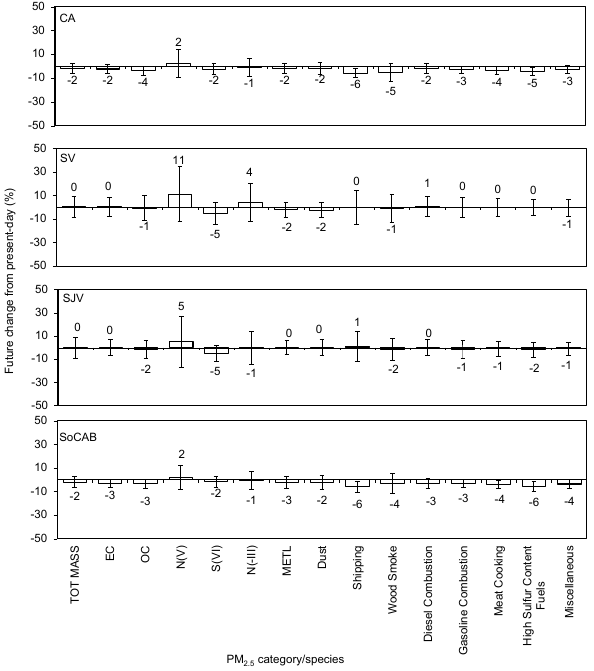
Fig. 2. Future (2047–2053) change in population-weighted annual-average concentrations of PM 2 . 5 total mass, primary and secondary components, and source categories contributing to the total mass from present-day (2000–2006). Panels (top-down) show California state-wide average, Sacramento Valley (SV) air basin average, San Joaquin Valley (SJV) air basin average, and South Coast Air Basin (SoCAB) average results. The error bars represent the 90% CI.